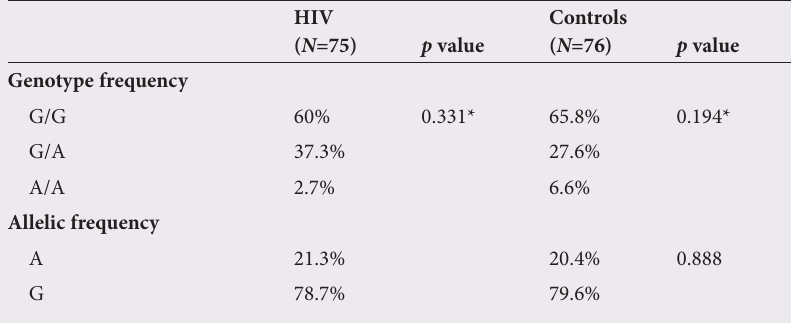
Table 1. Genotypic and allelic frequencies of the -308 TNF-α promoter region polymorphism in both HIV-positive and control populations